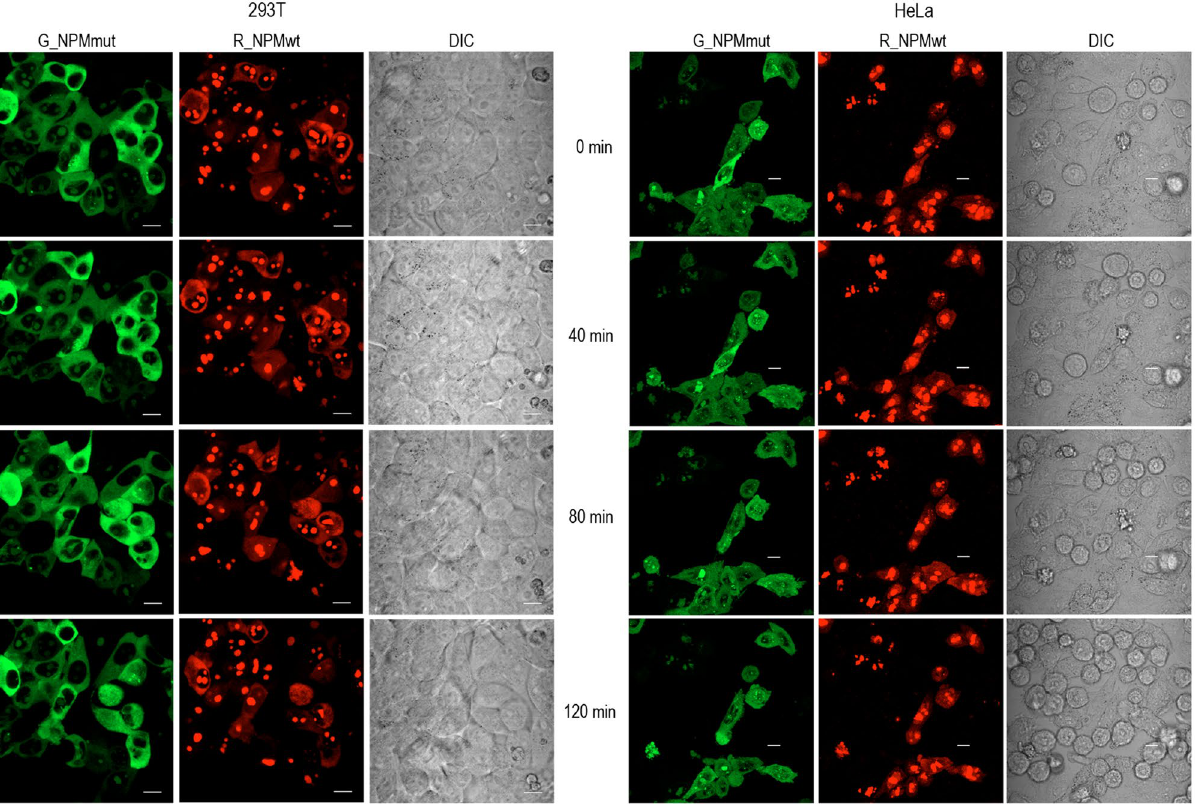
Figure 9. Time course of NSC348884-induced effects on the cell morphology. Effect of 10 µM NSC348884 was monitored in cells co-transfected with R_NPMwt (red) and G_NPMmut (green). The presence of the red signal in the cytoplasm and the cell morphology (DIC) were analyzed under confocal microscope. Left: 293T cells; right: HeLa cells. Scale bar represents 10